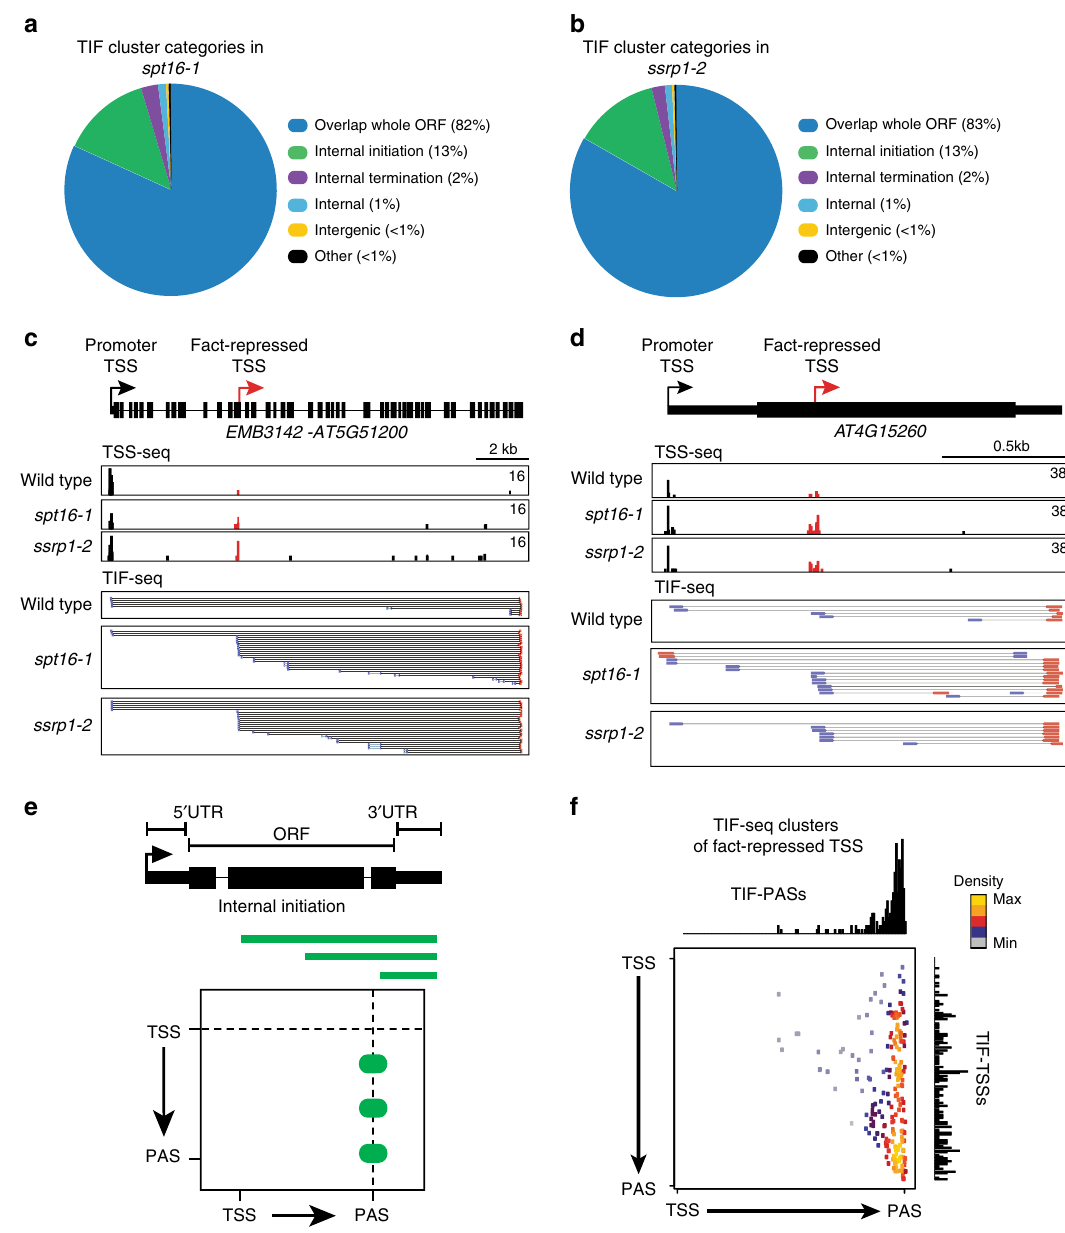
Fig. 2 The FACT complex represses initiation of intragenic isoforms. a Pie chart of TIF-cluster categories proportions present in spt16-1 . b Pie chart of TIF- cluster categories proportions present in ssrp1-2 . c , d Genome browser screenshots of the genes AT5G51200 ( c ) and AT4G15260 ( d ). TSS-seq data (top) for wild type, spt16-1 and ssrp1-2 , with fact-repressed intragenic TSS in red. TSS/PAS pairs by TIF-seq (below) are indicated as lines connecting TSSs (blue) and PASs (orange). Inverted TIF-cluster orientation for spt16-1 in d indicated antisense lncRNA isoforms. e Schematic representation of illustrating pro fi le of TIF-TSS/PAS pairs representing internal initiation. TIF-cluster and 2D illustration of their positions with respect to genome annotations are indicated in green lines and circles. f Scatterplot representing the TSS/PAS pair distance to annotated TSS/PAS for a subset of TIF-clusters from the combined spt16-1 and ssrp1-2 TIF-seq data sets. The selected data strictly overlap the published fact -speci fi c TSSs genomic positions identi fi ed through TSS-seq differential expression analysis in both spt16-1 and ssrp1-2 mutants. The colour scale represents 2D position enrichment density of clusters from low (grey) to high (yellow). Source data of a , b are provided in the Source Data fi